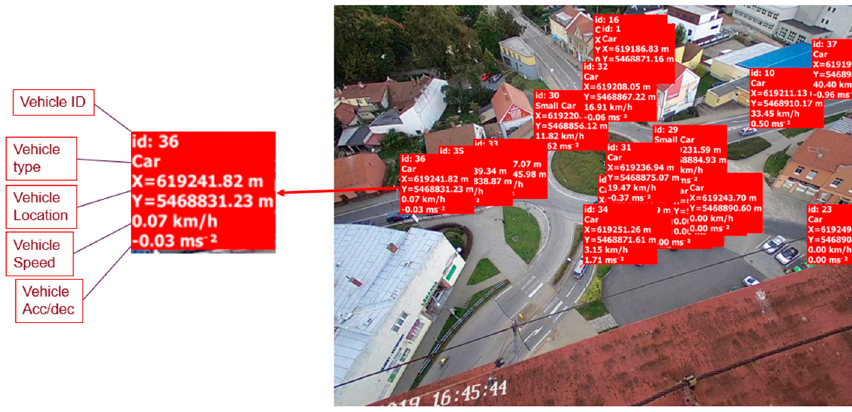
Figure 8. Video pre-processing and vehicle trajectory detection.